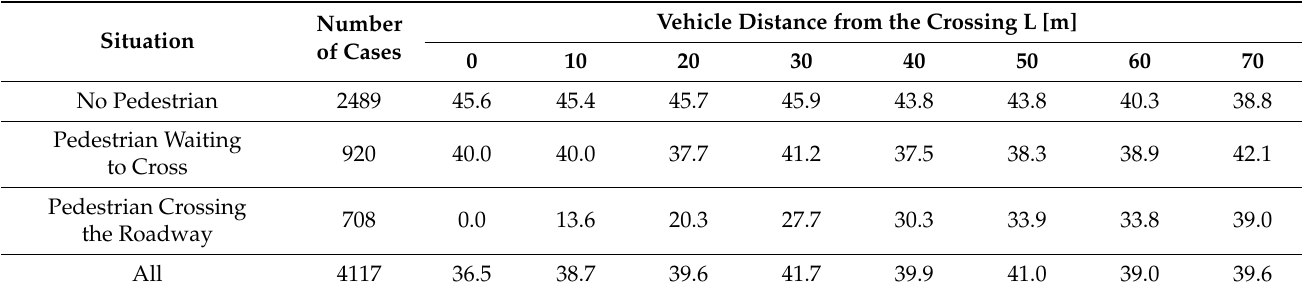
Table 2. Average vehicle speed V [km/h] depending on the distance from the pedestrian crossing L [m]. Situation Number of Cases to Cross